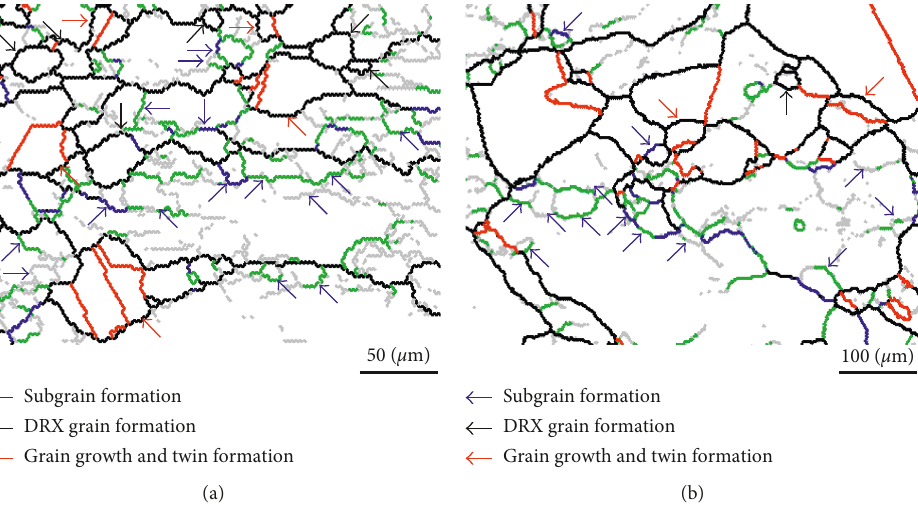
Figure 9: Microstructure in the region enclosed by the dashed rectangle in (a) Figure 1(c) and (b) Figure 3(b) at higher